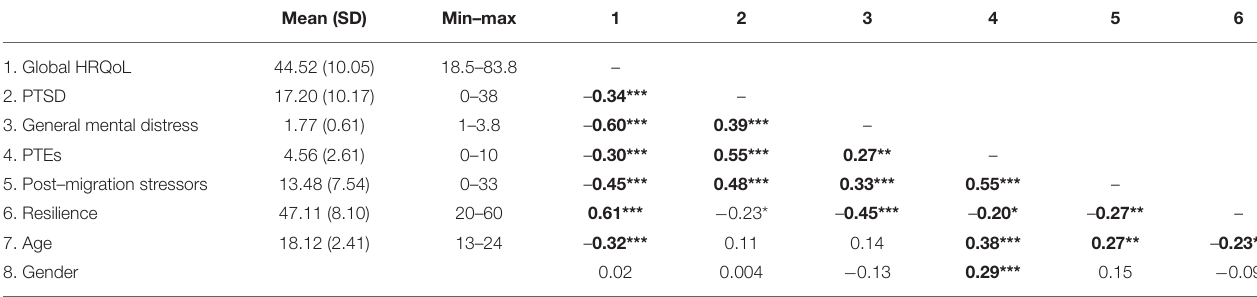
TABLE 2 | Correlations between main study